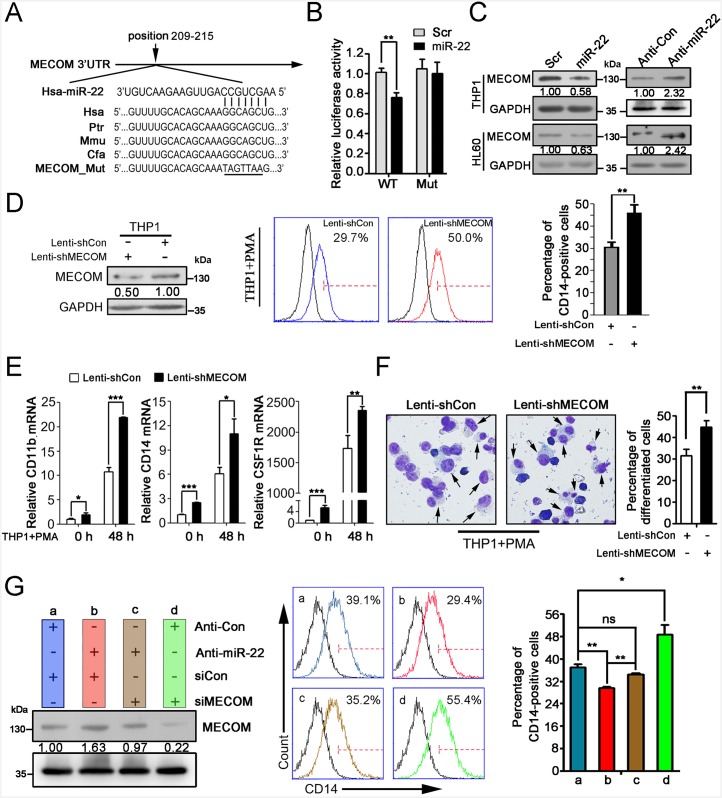
miR-22 directly targets MECOM mRNA to regulate monocyte/macrophage differentiation.A. The predicted miR-22 binding site in the 3’UTR of MECOM mRNA. MECOM_Mut represents the mutant 3’UTR of MECOM. The mutated sequence is underlined. B. Relative luciferase activity of the indicated reporter constructs demonstrated that miR-22 bound to the 3’UTR of MECOM and repressed its expression. WT or Mut represent recombinant pMIR-REPORT plasmids containing the wild 3’UTR or the mutant 3’UTR of MECOM. Error bars represent SD (n = 3). (**P<0.01, Student’s t-test). C. Ectopic expression of miR-22 decreased while inhibition of miR-22 increased endogenous MECOM levels in HL-60 and THP1 cells. D. Flow cytometry analysis demonstrated that MECOM knockdown increased the percentage of CD14-positive cells. The black-line curve represents the unstained cells. Western blotting confirmed MECOM knockdown in the THP1 cells infected with Lenti-shMECOM (left). A representative experiment is presented in the middle columns and a statistical analysis is presented on the right. Error bars represent SD (n = 3). (**P<0.01, Student’s t-test). E. The MECOM knockdown promoted CD11b, CD14, and CSF1R mRNA expression. Error bars represent SD (n = 3). (*P<0.05, **P<0.01, ***P<0.001, Student’s t test). F. May-Grünwald Giemsa staining showed that MECOM knockdown promoted the maturation of monocytes/macrophages. The cells were observed under 400 X magnification. The arrows pointed differentiated monocytes/macrophages. A statistical analysis for counting differentiated monocyte/macrophages in five fields is presented in the right. (**P<0.01, Student’s t test). G. Rescue assays. THP1 cells were transfected with anti-Con or anti-miR-22 for 24 hours, re-transfected with siCon or siMECOM for another 24 h, and then the differentiation was induced by PMA for 48 hours and harvested. A representative immunoblotting of MECOM is shown on the left, a representative flow cytometry assay using the CD14 antibody is displayed in the middle, and a statistic analysis is presented in the right. Error bars represent SD (n = 3). (*P<0.05, **P<0.01, ns: no significance, Student’s t test).